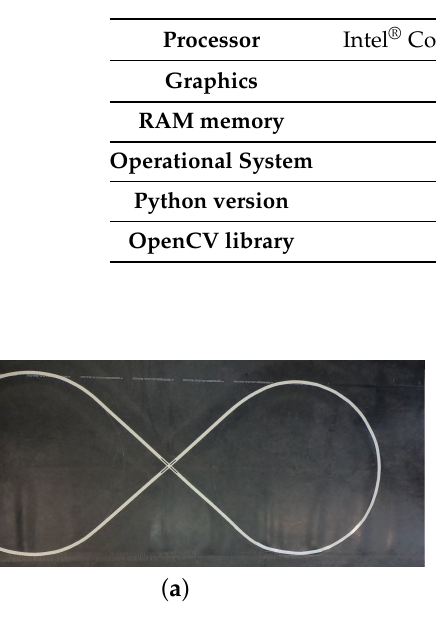
Table 4. Hardware and software description.